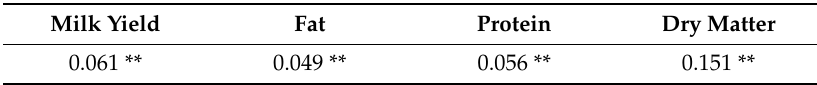
Table 5. Pearson product-moment correlation coe ffi cients between the predicted breeding values (PBV) for milk yield and fat, protein and dry matter (in kg) obtained using both a model involving the α S1- casein genotype and one excluding it for all the animals included in the pedigree ( n = 29,397) of the Murciano Granadina goat breed. Regression equations for the predicted breeding values for milk yield, and components obtained after both models to determine the possibility of excluding genotype from the routine genetic evaluation of the breed given the costs involved in genotyping, are shown in Figure 1.